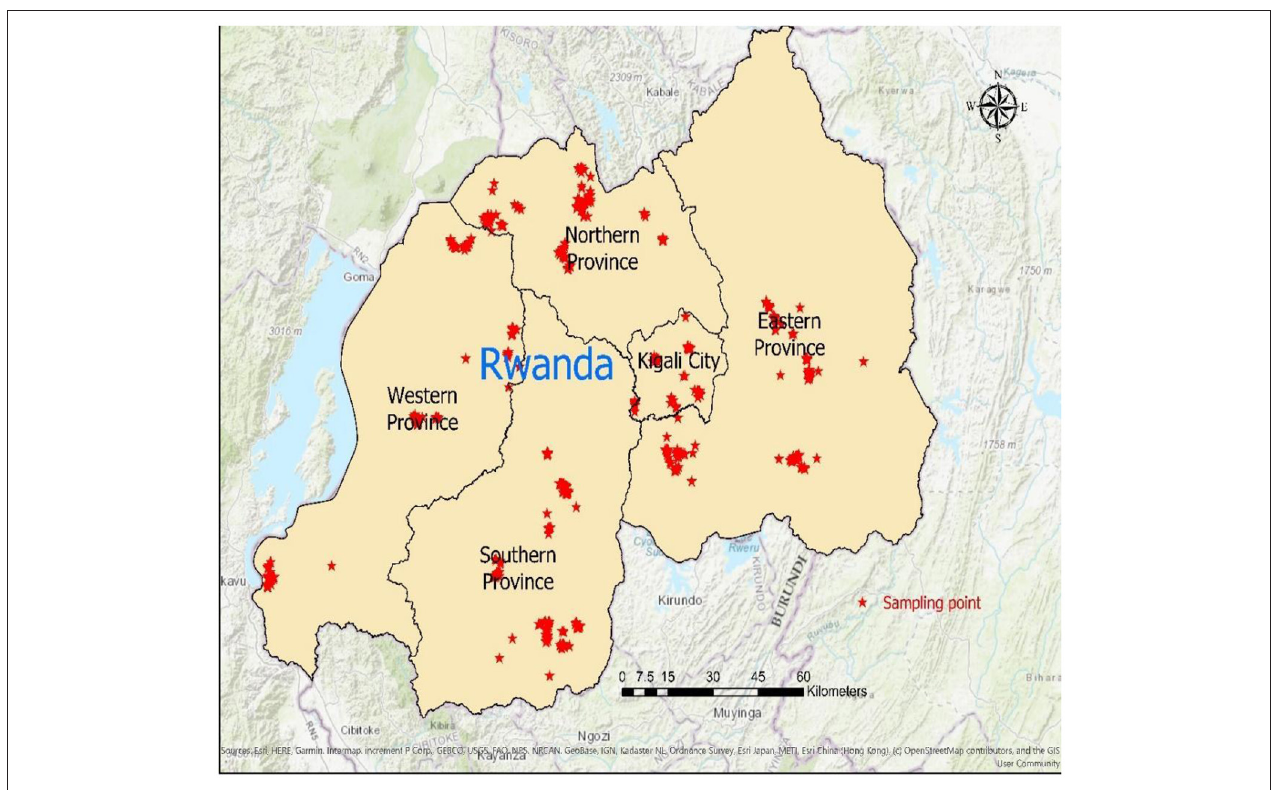
FIGURE 1 | Survey Area and sample points for Rwanda.